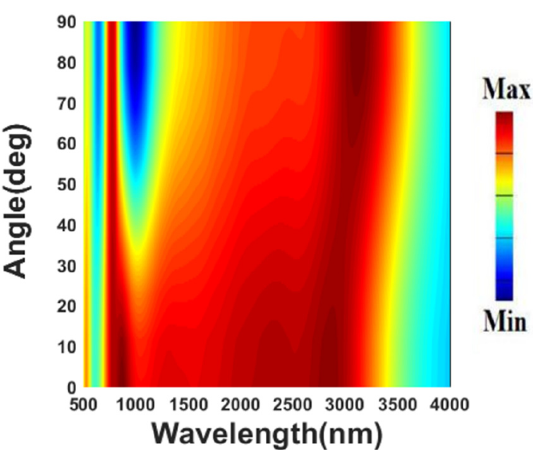
Figure 8. Absorption spectra of the absorber at different polarization angles.